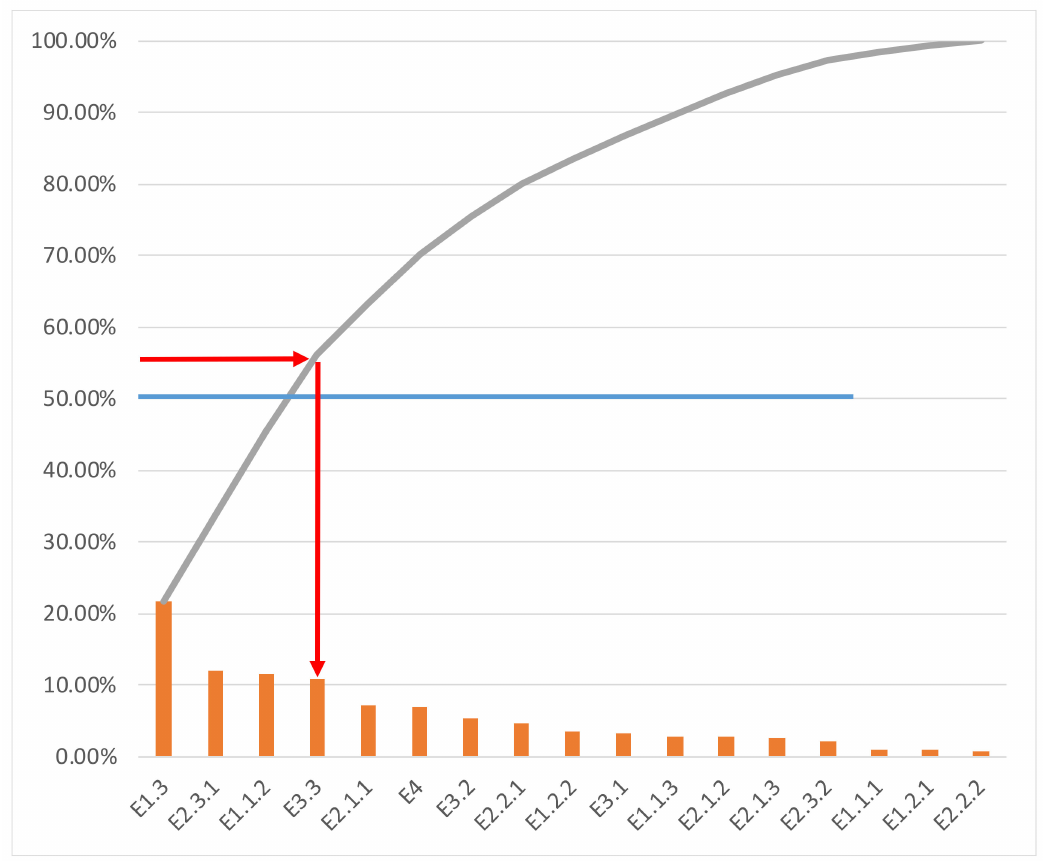
Figure 3. Application of the criterion “up to 50%” to select the most relevant environmental elements according to the group of